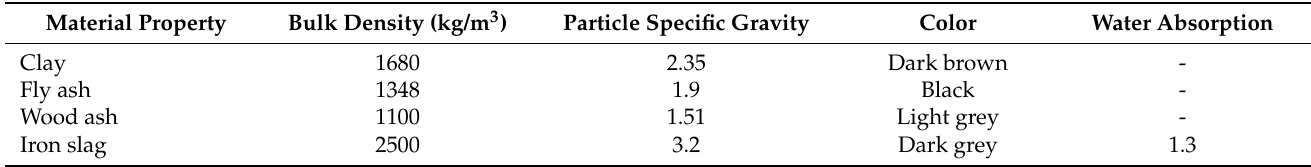
Table 3. Physical properties of the constituent